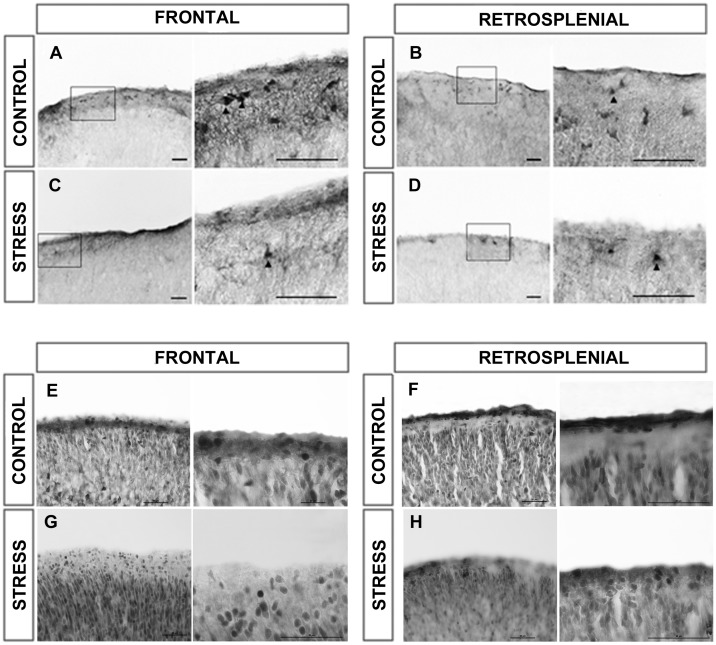
Cerebral cortex reelin and NeuN immunohistochemistry.Microphotographies of the dorsal tier of frontal (A, C, E, G), and retrosplenial (B, D, F, H) cortical levels. Control brains (A, B) show numerous clusters of Cajal-Retzius neurons while the stress groups (C, D) show only few isolated Cajal-Retzius neurons. Total neuronal density is show in Control brains (E, F) and stress group (G, H). No differences between groups are observed. Scale bars = 50 μm.